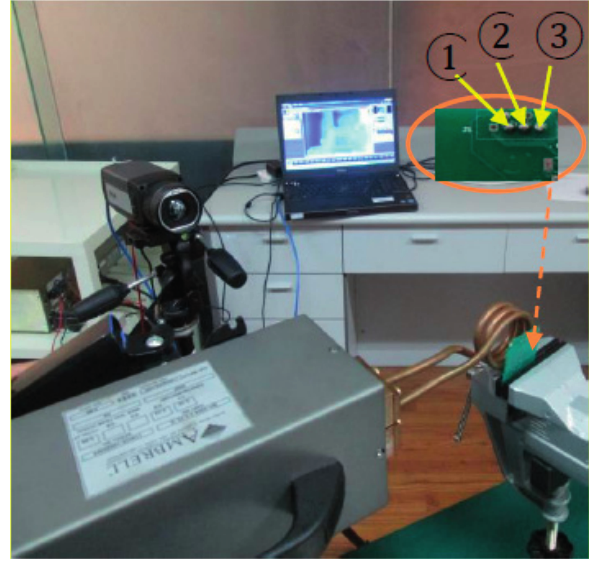
Figure 11. Experiment set-up, where (1), (2) and (3) represent the crack solder ball, the intact solder ball and the void solder ball